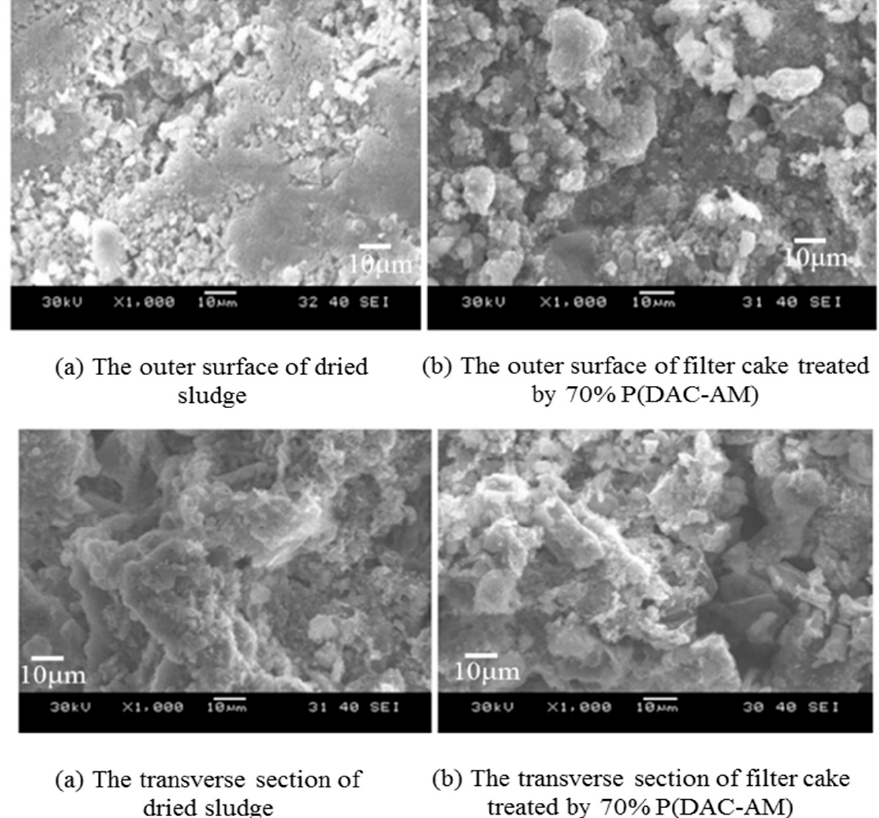
Figure 7. The outer surface and transverse section of dried sludge filter cake treated by P(DAC-AM) [94].